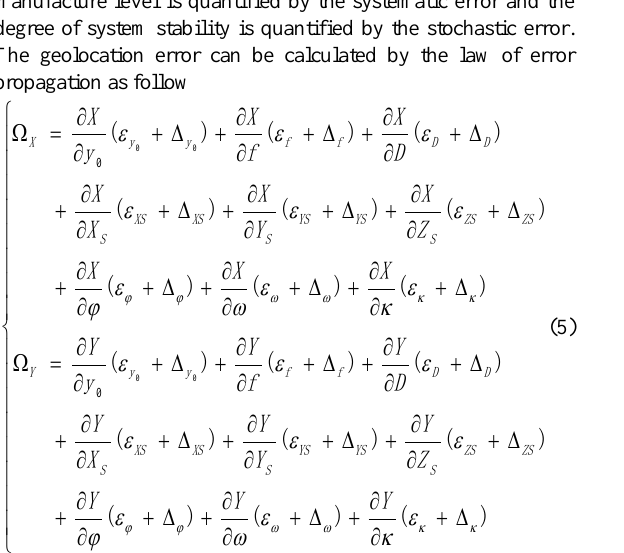
Figure 2. Detectors of nadir camera